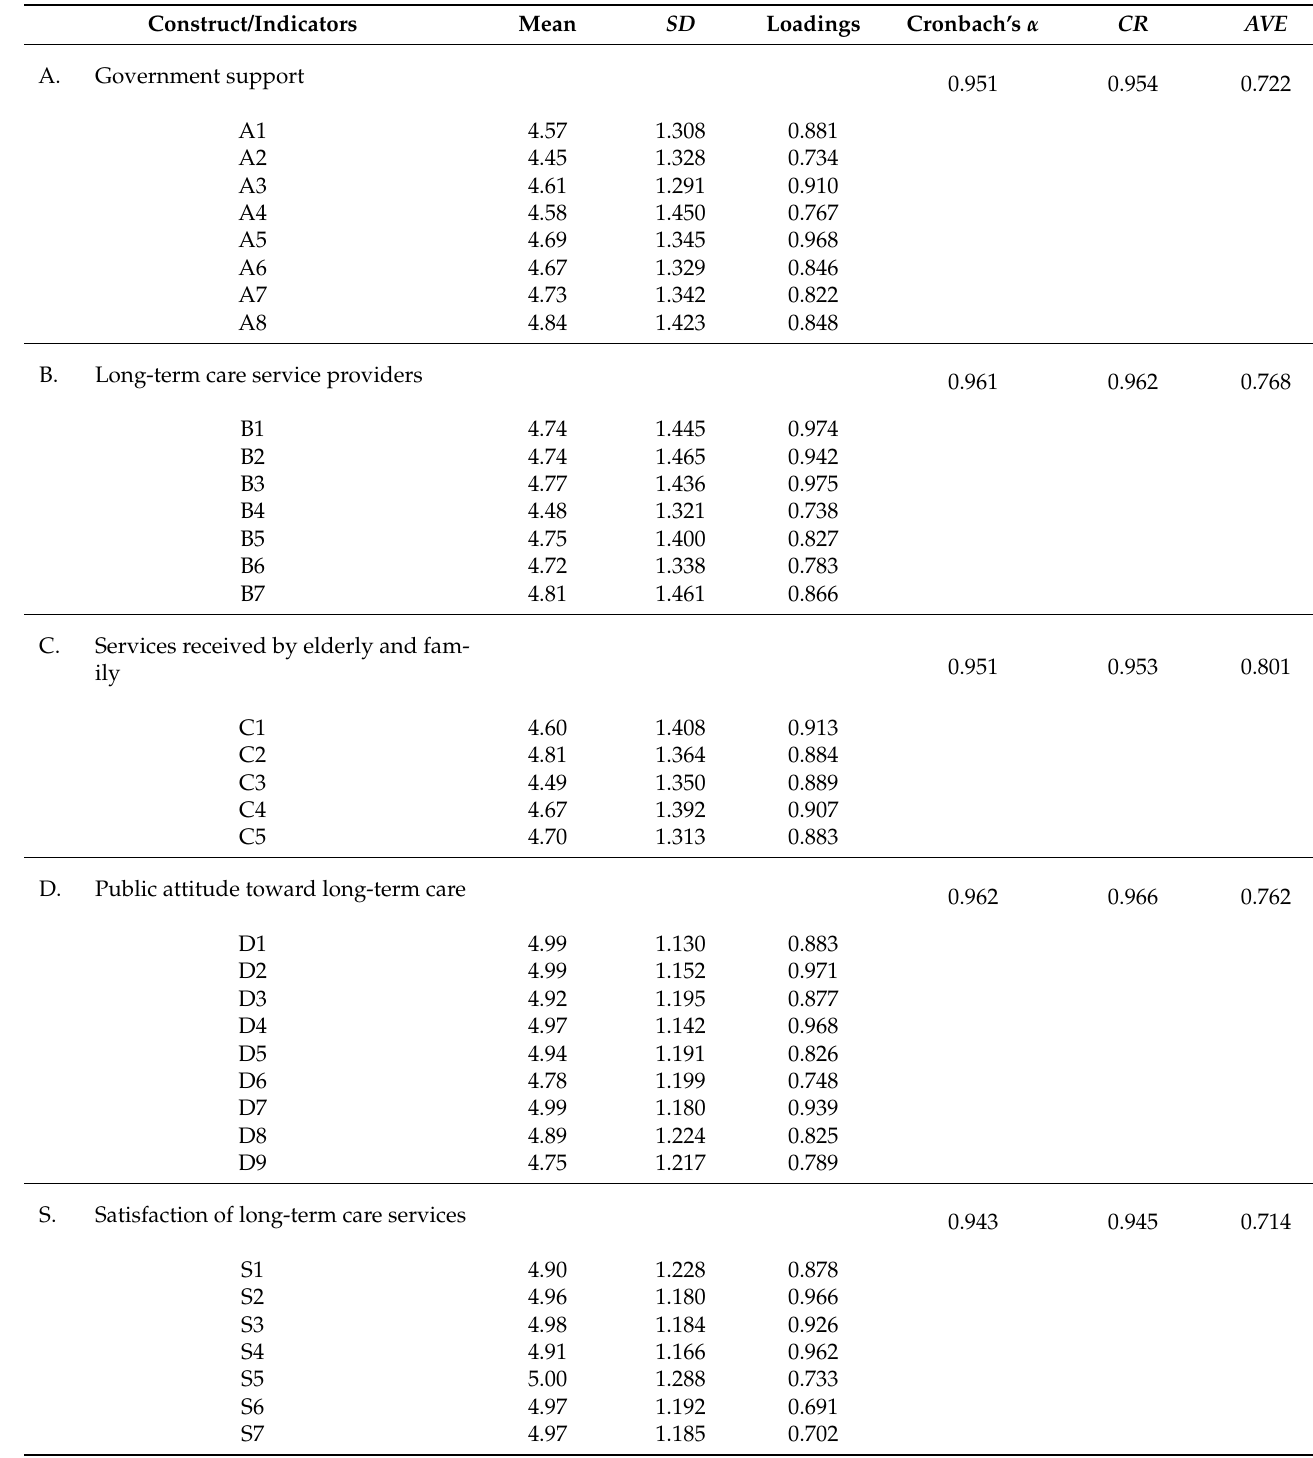
Table 4. Measurement model